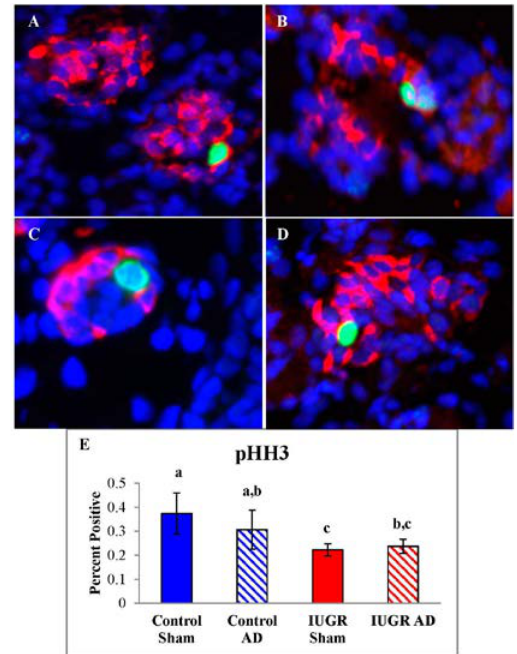
Figure 6. β-cell Proliferation Rates. Pancreas tissues were immunostained for phosphorylated-Histone H3 (pHH3; green), insulin (β-cells; red), and nuclear DNA (DAPI; blue). Representative micrographs are presented for control-sham ( A ); control-AD ( B ); IUGR-sham ( C ); and IUGR-AD ( D ). The mean (±SEM) percentages of pHH3 positive β-cells are graphed for treatment groups labeled on the x-axis ( E ). Error bars represent the SEM and different superscripts denote statistically significant differences among treatment groups ( p <